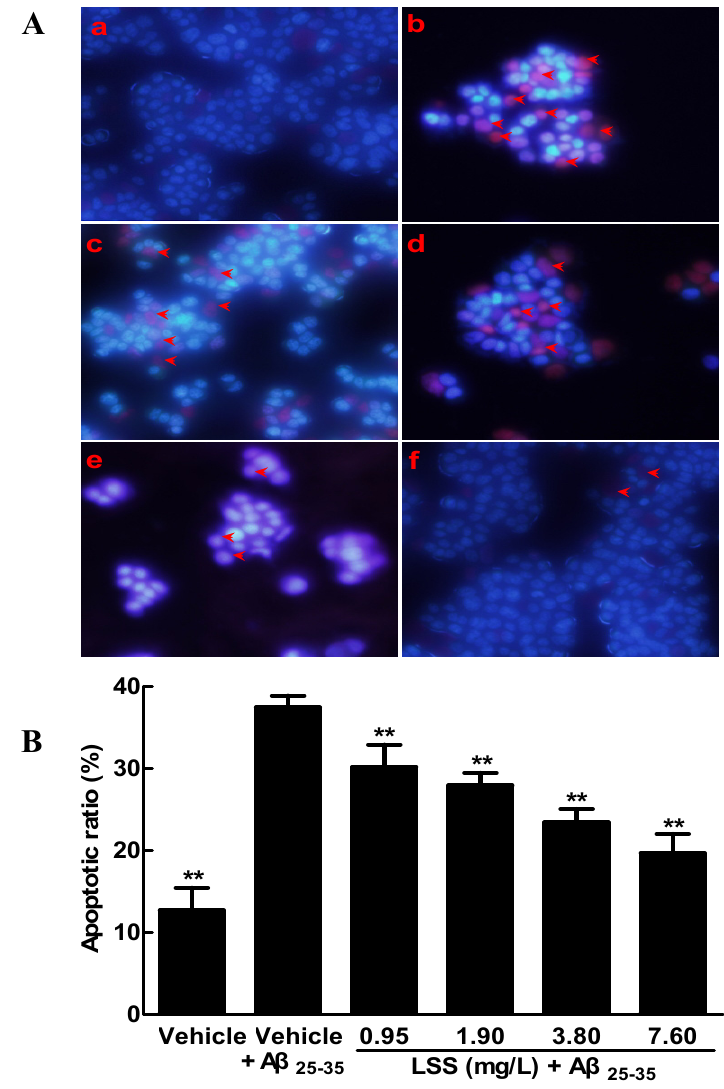
Figure 1. Effect of LSS on apoptosis induced by A β 25 ‐ 35 (20 μ mol/L) in PC12 cells with Hoechst 33342/PI staining under fluorescence microscope (400×). ( A ) Representative pictures of PC12 cells treated with or without LSS; ( Aa ) cells were treated with medium for 13 h without A β 25 ‐ 35 ; ( Ab ) cells were treated with medium for 1 h and followed by A β 25 ‐ 35 for 12 h; ( Ac ) cells were treated with LSS 0.95 mg/L for 1 h and followed by A β 25 ‐ 35 for 12 h; ( Ad ) cells were treated with LSS 1.90 mg/L for 1 h and followed by A β 25 ‐ 35 for 12 h; ( Ae ) cells were treated with LSS 3.80 mg/L for 1 h and followed by A β 25 ‐ 35 for 12 h; ( Af ) cells were treated with LSS 7.60 mg/L for 1 h and followed by A β 25 ‐ 35 for 12 h. The red arrows indicate apoptotic cells; ( B ) Summarized results of apoptotic ratio. The results are representative of at least three independent experiments run in triplicate and expressed as mean ± SD. ** p < 0.01 vs. cells treated with vehicle and A β 25 ‐ 35 .